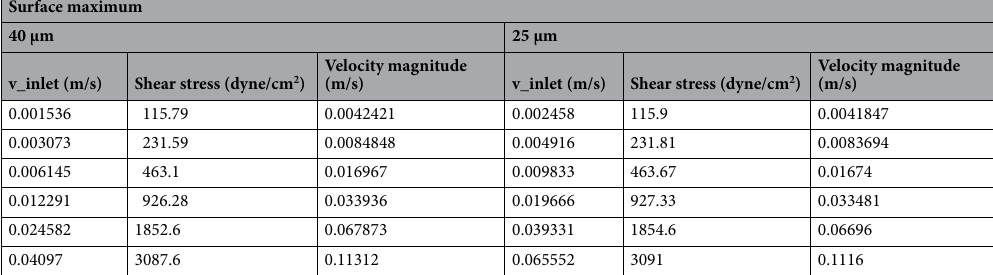
Surface maximum 40 μm 25